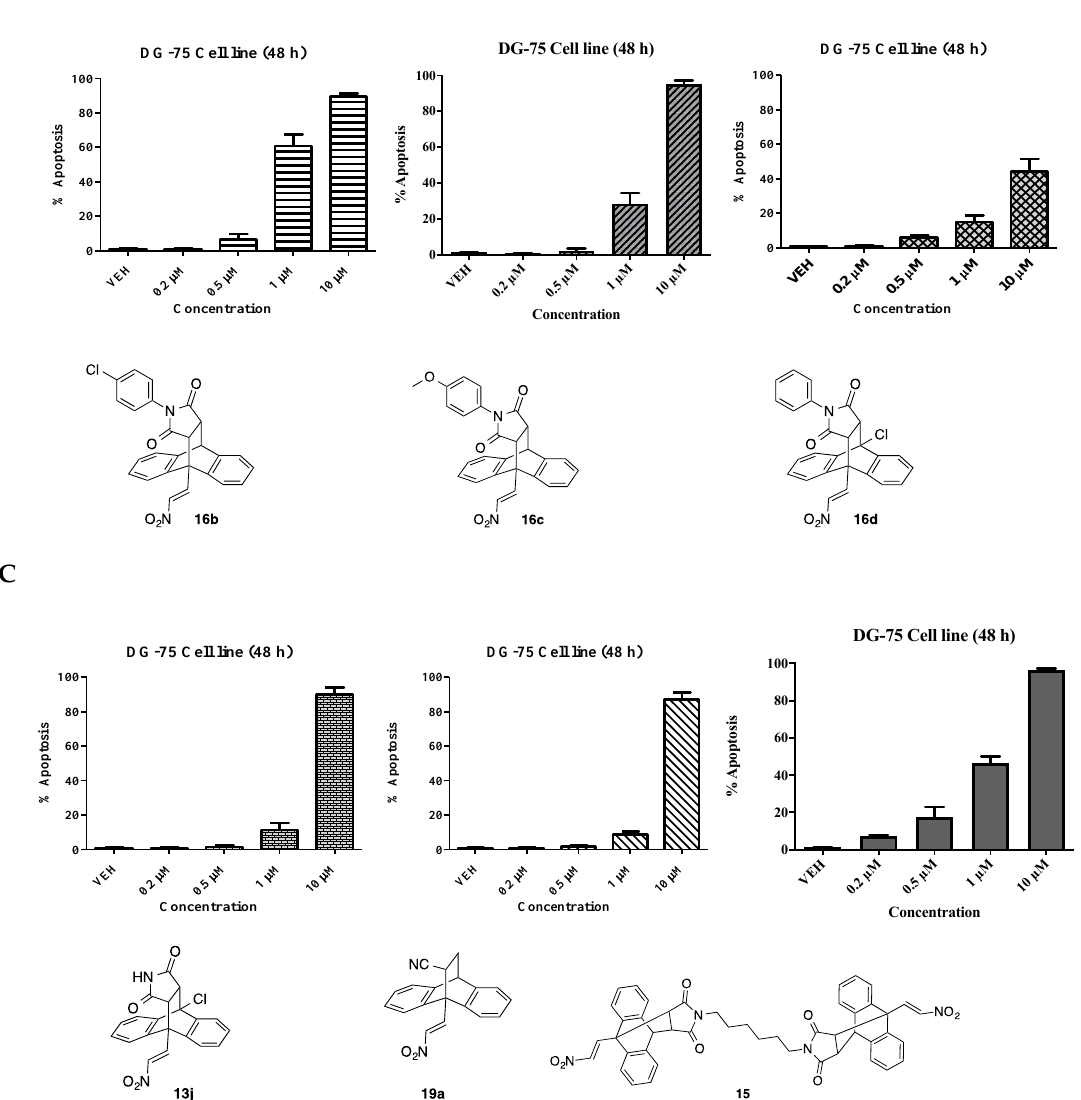
Figure 5. Ethanoanthracene nitrostyrene compounds 16a – d , 13j , 19a , 15 induce apoptosis in Burkitt’s lymphoma DG-75 cell line. Induction of apoptosis in Burkitt’s lymphoma DG-75 cell line following treatment for 48 h with selected ethanoanthracene nitrostyrene compounds (0.2 – 10 μ M) or a comparative control (taxol) in DG-75 cell line is determined by Annexin V and propidium iodide staining/FACS: ( A ) Taxol, 12 , 16a ; ( B ) 16b , 16c , 16d ; ( C ) 13j , 19a , 15 . Ethanol was used as the vehicle. Values represent the mean of three independent experiments.